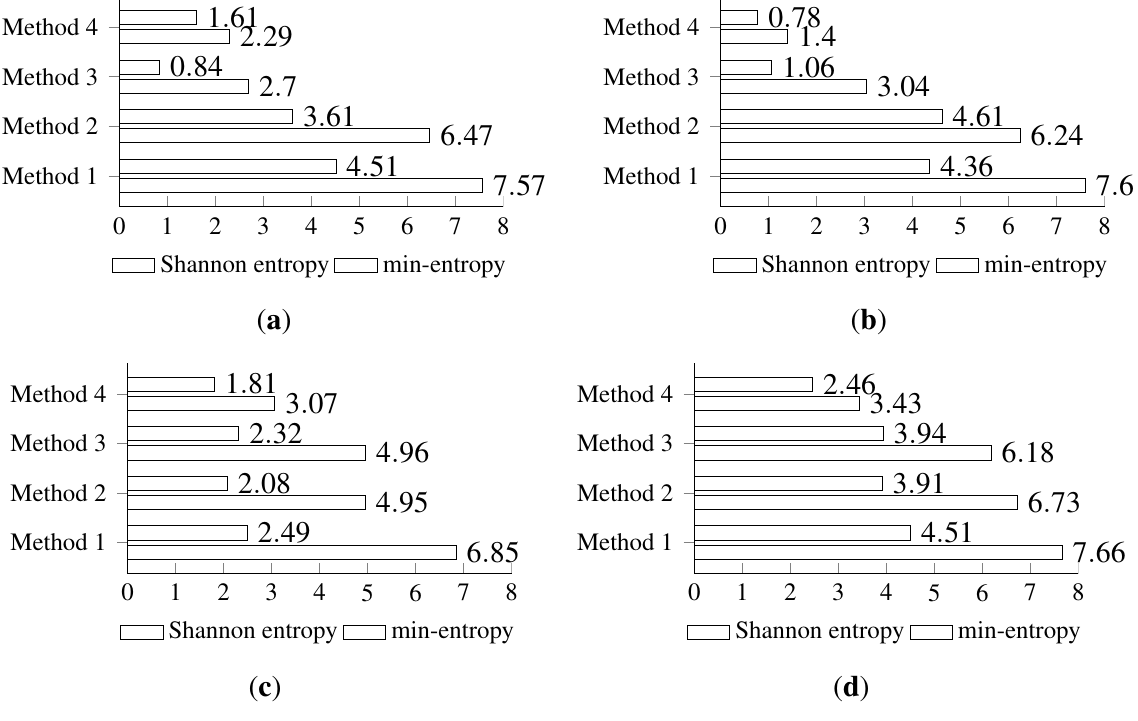
Figure 3. The comparison of the measured Shannon and min-entropy of the initial experimental results. ( a ) Light (1); ( b ) Light (2); ( c ) humidity; ( d )